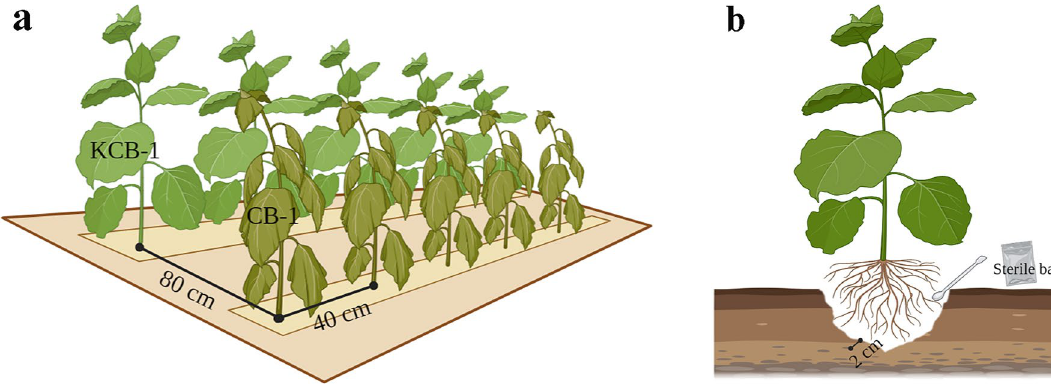
Figure 1. Planting distribution and rhizosphere soil sampling patterns of KCB-1 and CB-1. ( a ) Planting distribution of KCB-1 and CB-1. ( b ) Rhizosphere soil sampling pattern of KCB-1 and CB-1. Images drawing by BioRender (https:// biore nder.